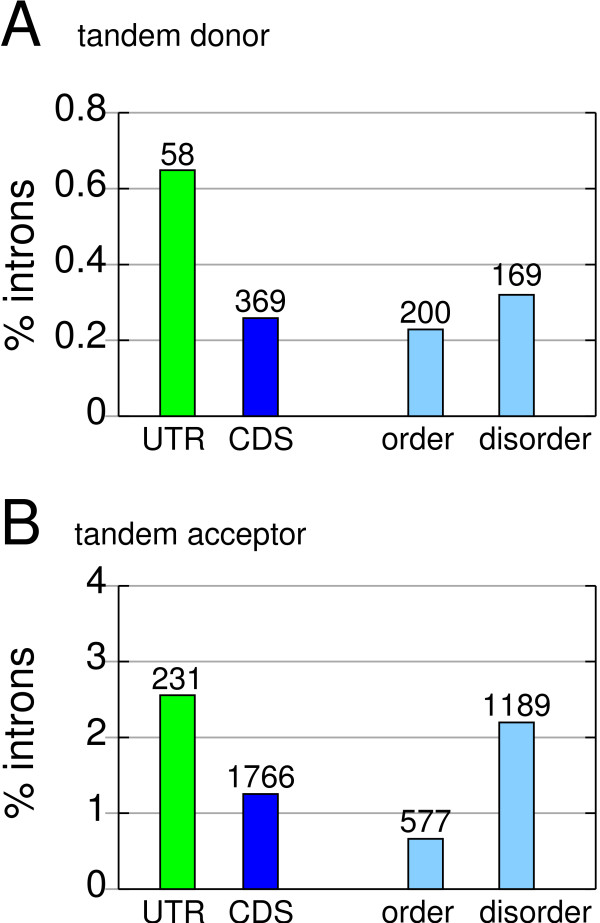
Frequency of tandem splice sites in the CDS and UTR. Each bar is the percentage of human introns having a tandem donor (A) or acceptor (B). Introns are divided into a location in the CDS (blue) and the UTR (green). CDS introns are further divided into a location in ordered and disordered protein regions (light blue). Absolute numbers are given above the bars.